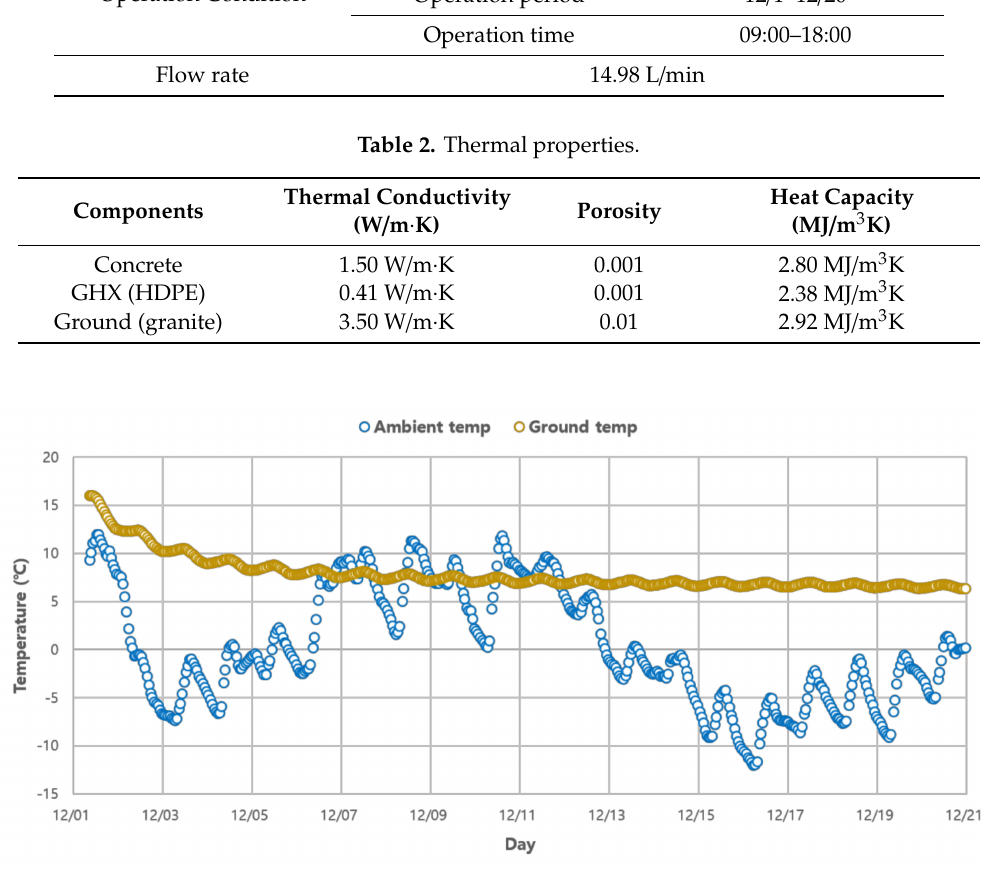
Figure 4. Ground and ambient